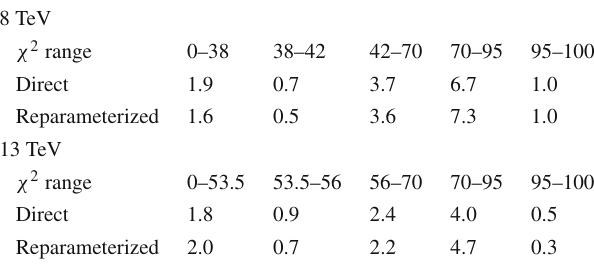
Table 4 Mean errors of the neural networks for the 8 TeV and 13 TeV LHC χ 2 prediction in different ranges. The results for the direct and reparameterized approach (Sect. 4) are